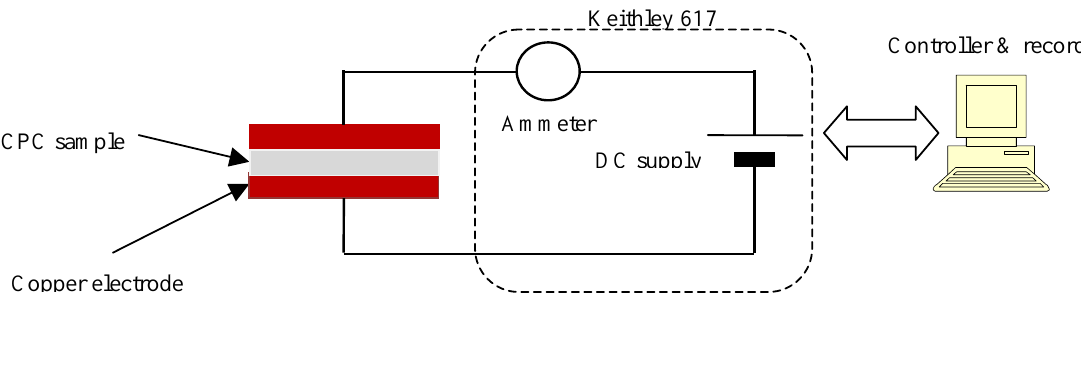
Figure 2. Experimental set-up of electrical resistance measurement on CPC